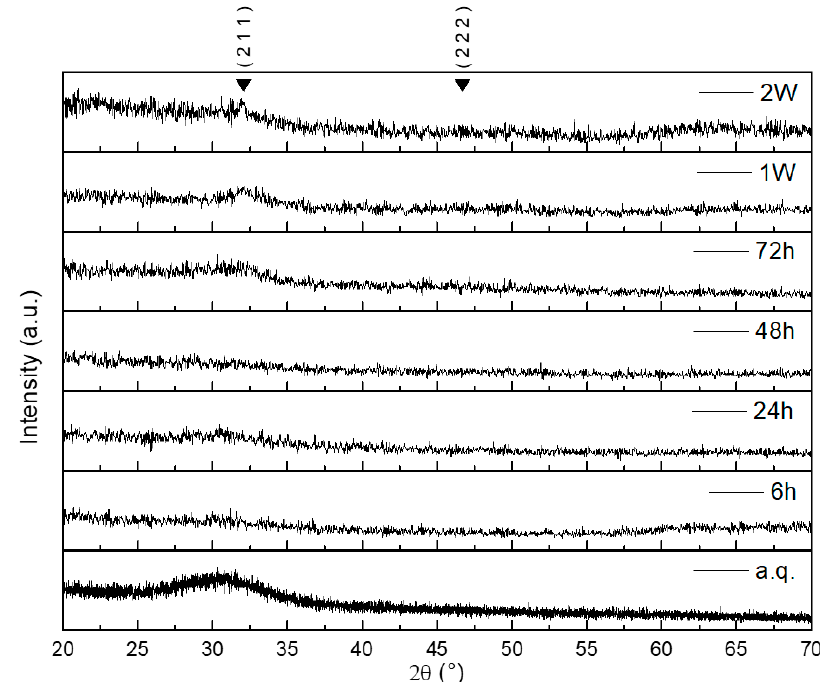
Figure 6. XRD patterns of graded 47.5B glass scaffolds after soaking in simulated body fluid (SBF) for different time frame. The main hydroxyapatite (HA) peaks are indicated by the Miller indices (h k l).